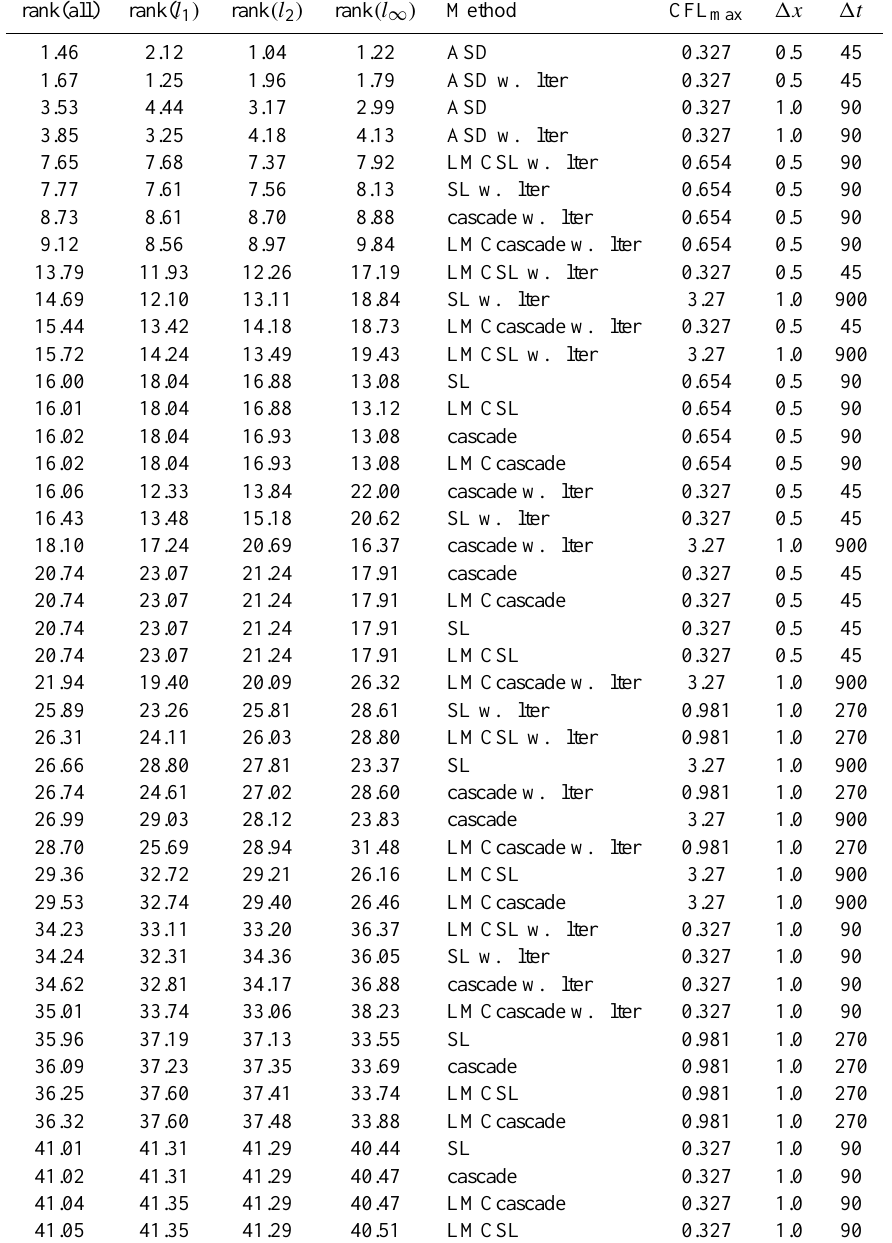
Table 1. Ranking results for the rotating cone with rural chemistry. Showing rank of the ranked error measures, rank of error measure l 1 , l 2 , and l ∞ followed by method, maximum Courant number, grid resolution, and time